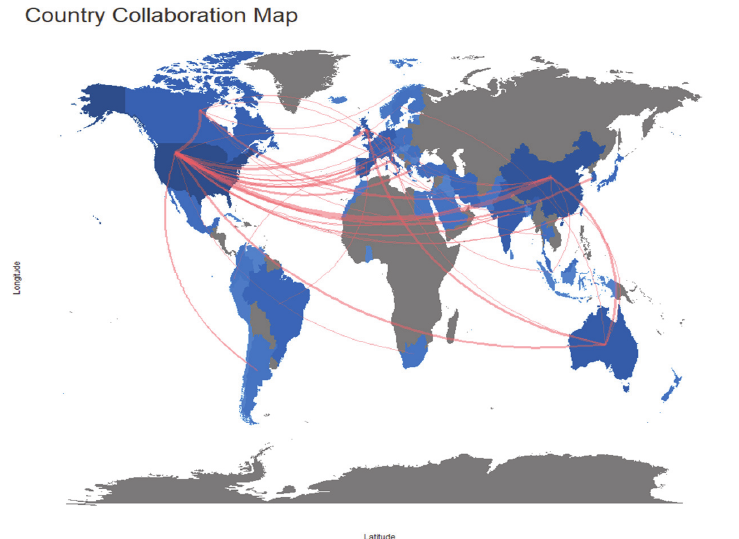
Fig. 2. Country collaboration